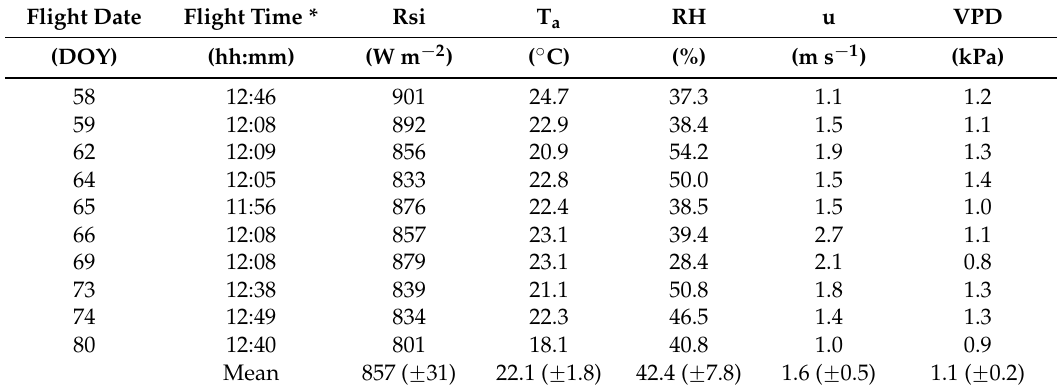
Table 1. Meteorological conditions at the time of UAV overpass during the 2014 study